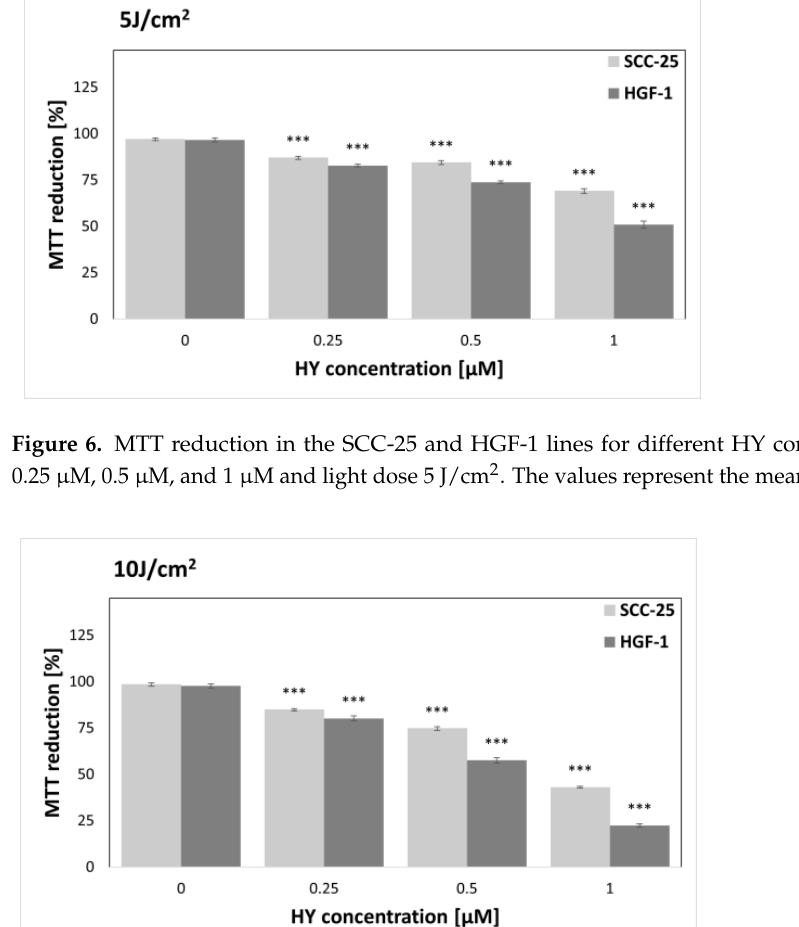
Figure 7. MTT reduction in the SCC-25 and HGF-1 lines for different HY concentrations: 0 µM, 0.25 µM, 0.5 µM, and 1 µM and light dose 10 J/cm 2 . The values represent the means ± SE. *** p < 0.01.